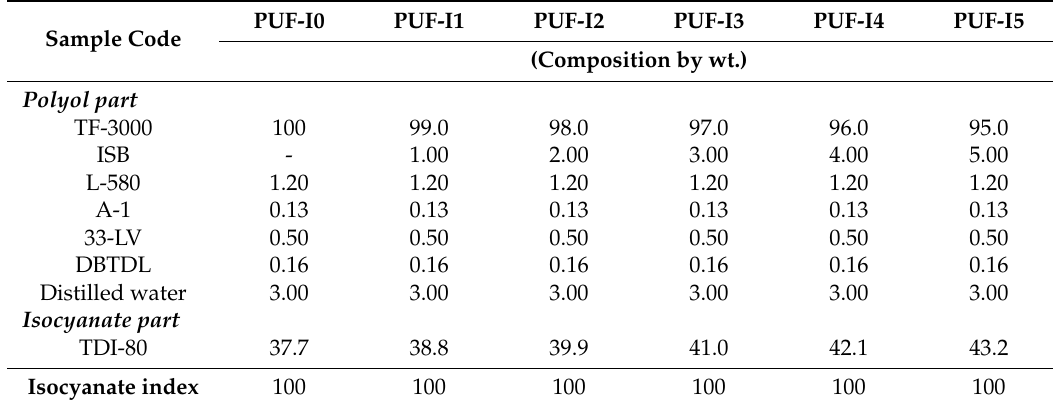
Table 1. Sample code and formulation for FPUFs with various amounts of